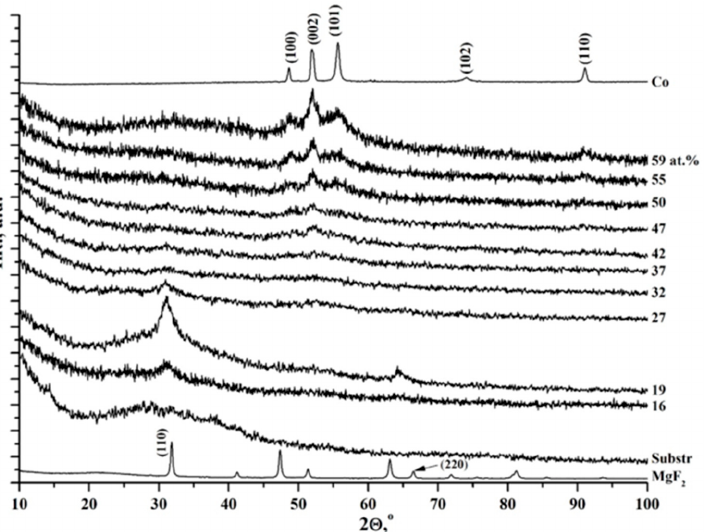
Figure 1. XRD patterns of Co x (MgF 2 ) 100–x nanocomposites of various compositions on glass sub- strates [25]. strates